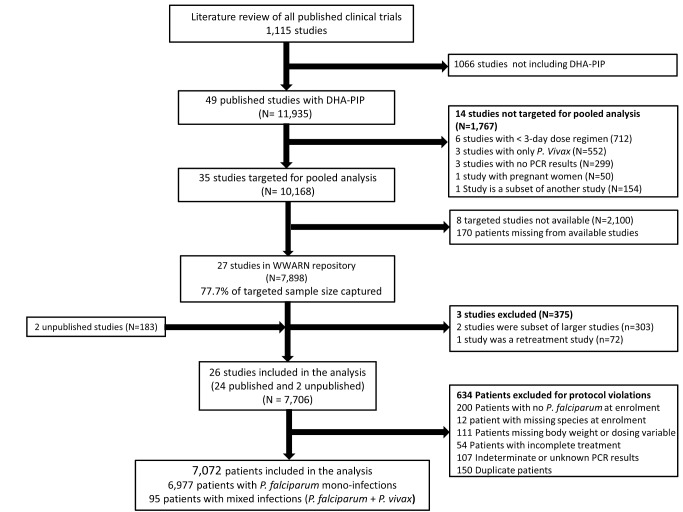
Patient flowchart.